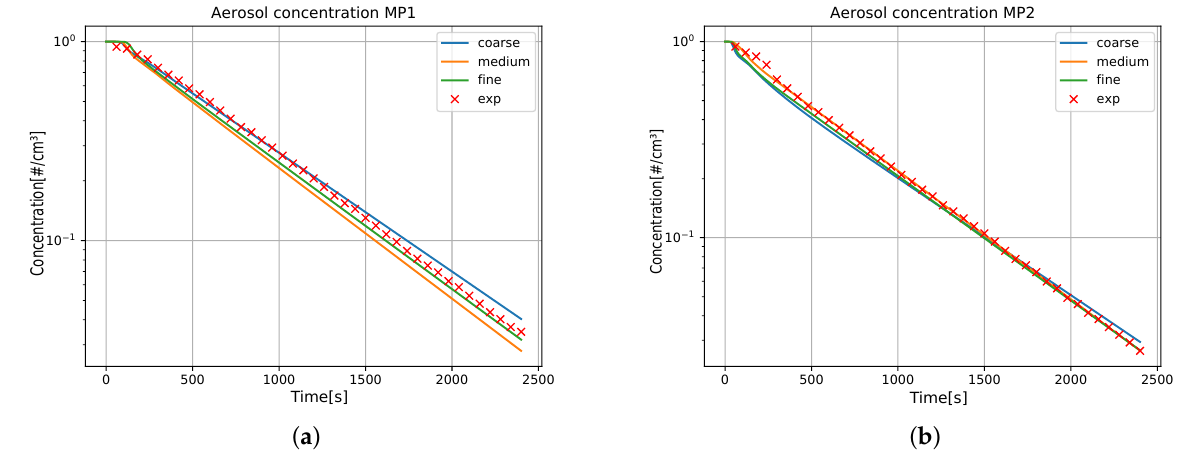
Figure 4. Aerosol concentration for position ( a ) MP1 and ( b ) MP2. The key exp refers to the experimental data and coarse, medium, and fine refer to the mesh size of simulations.